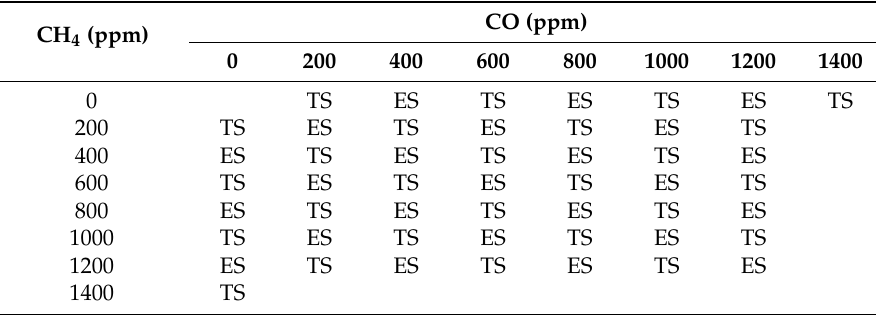
Table 1. Experimental sample